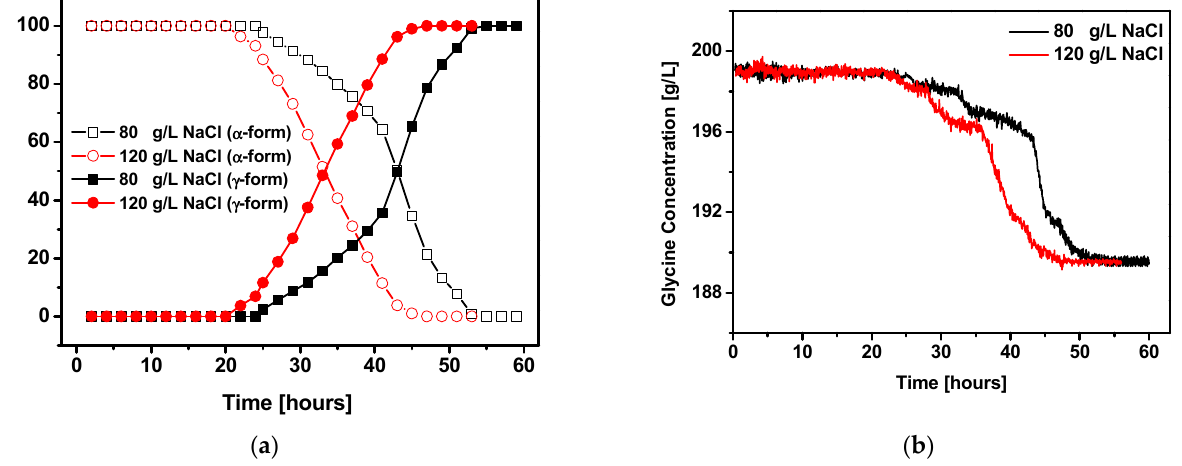
Figure 6. Influence of NaCl concentration on glycine polymorphic phase transformation of glycine α -form to γ -form. ( a ) Solid fraction of γ -form and α -form glycine; ( b ) glycine solution concentration during crystallization. The agitation speed, temperature, and seed concentration were fixed at 750 rpm, 20 ° C , and 60 g/L, respectively.